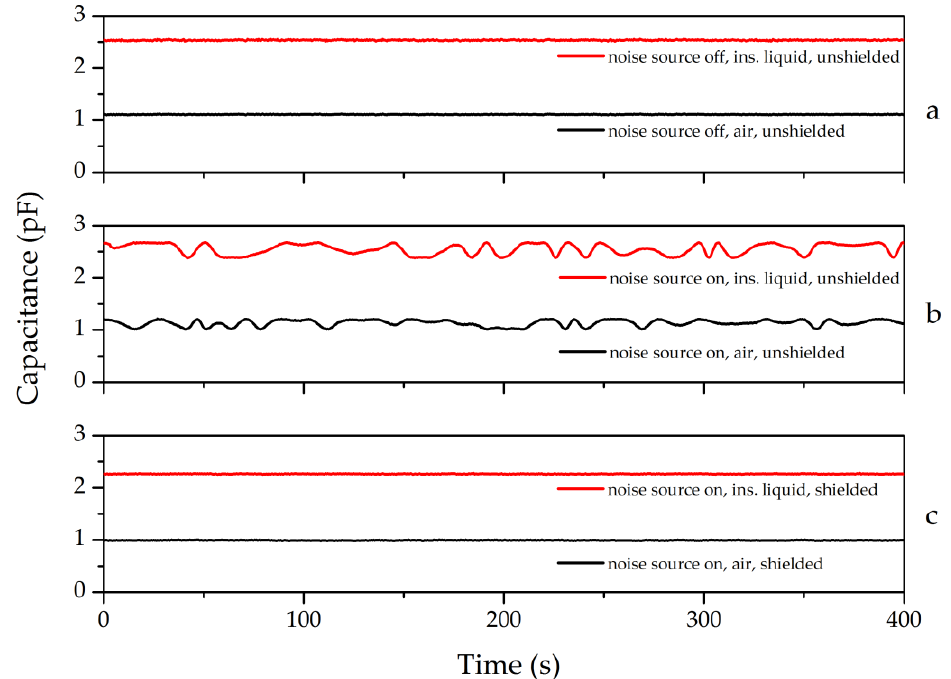
Figure 10. The validation of shield function for λ = 4 mm. ( a ) In the absence of an applied potential on the power supply cord, no instabilities are exhibited; ( b ) After applying voltage onto the cord, fluctuations are observed; ( c ) Measurement of capacitance with a Faraday shield in place.